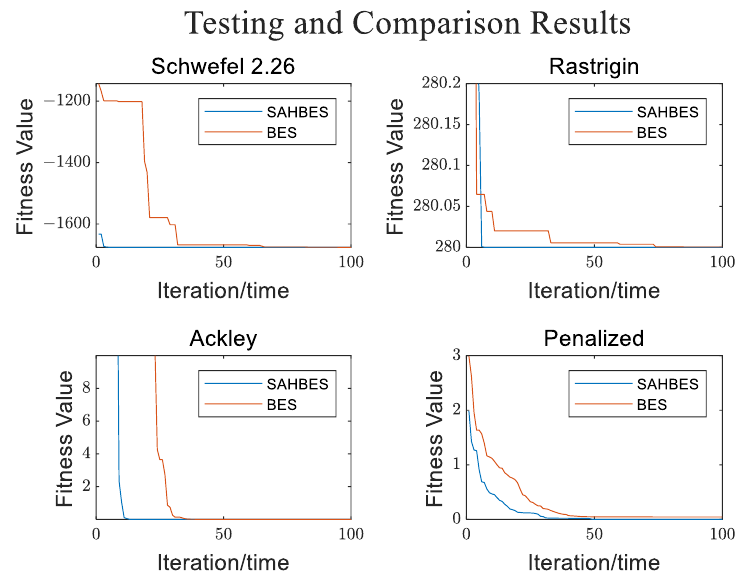
Figure 3. Comparison of the test functions’ fitness value curve .